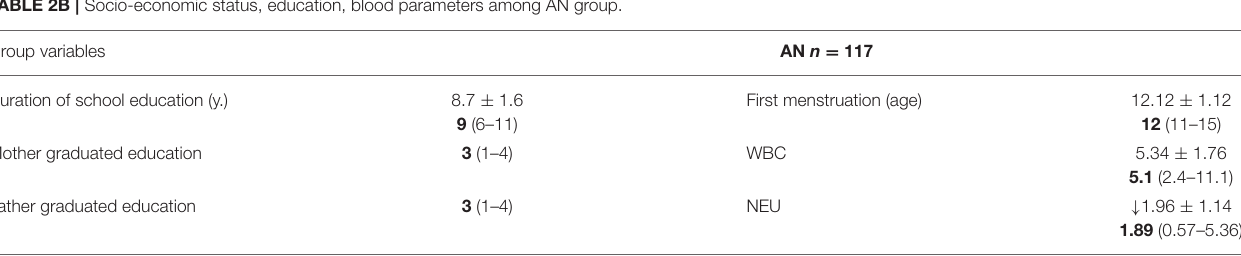
TABLE 2B | Socio-economic status, education, blood parameters among AN group. Group variables AN n = 117 Duration of school education